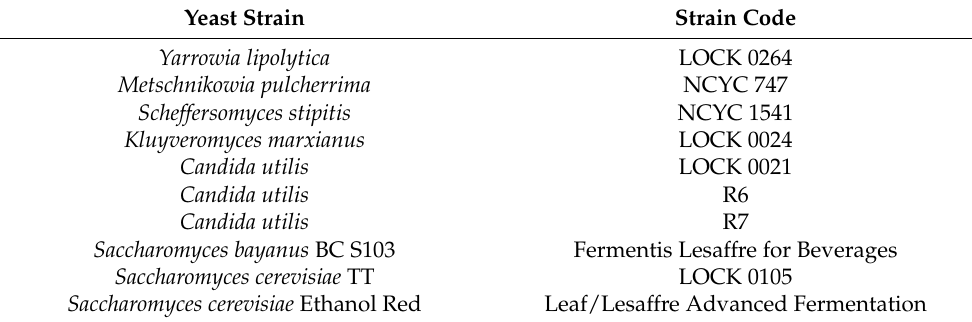
Table 4. Yeast strains used in the study.